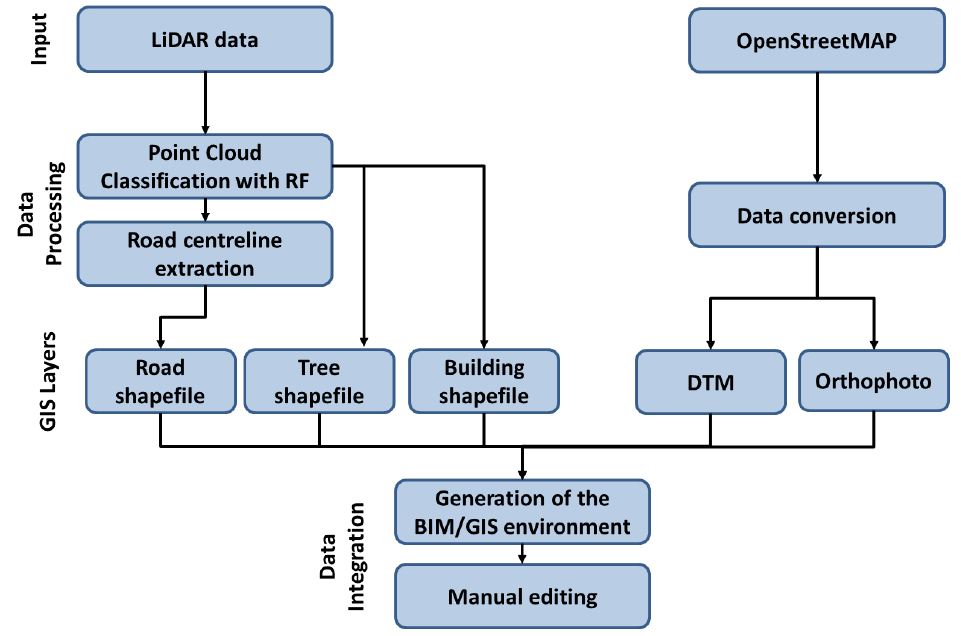
Figure 4. Schematic workflow of the proposed procedure: from input data to the production of an integrated BIM/GIS. RF: Random Forest; DTM: Digital Terrain Model.